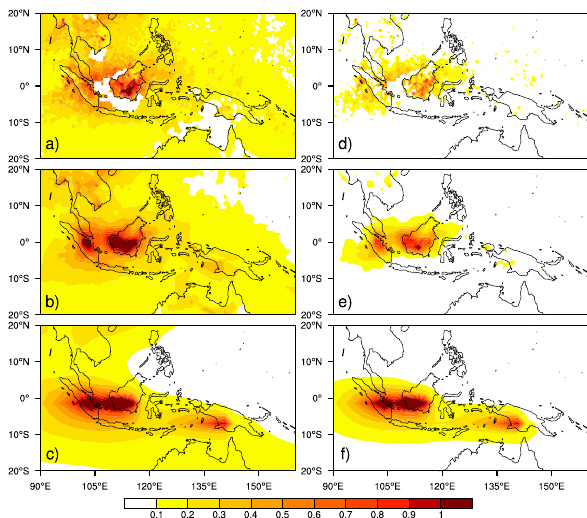
Fig. 4. Aerosol optical depths from satellite and model simulations during high and low fire years. (a) August–October mean AOD from MISR for moderate El Ni˜no years (the mean of 2002, 2004, and 2006), (b) MODIS AOD for same period, (c) CAM-simulated AOD for the high fire simulation (forced with 1997 emissions), (d) The difference in August–October MISR AOD between moderate El Ni˜no (2002, 2004, 2006) and La Ni˜na (2000, 2001, 2005) years, (e) MODIS AOD differences for the same two periods, (f) CAM- simulated AOD for the difference between the high fire and low fire